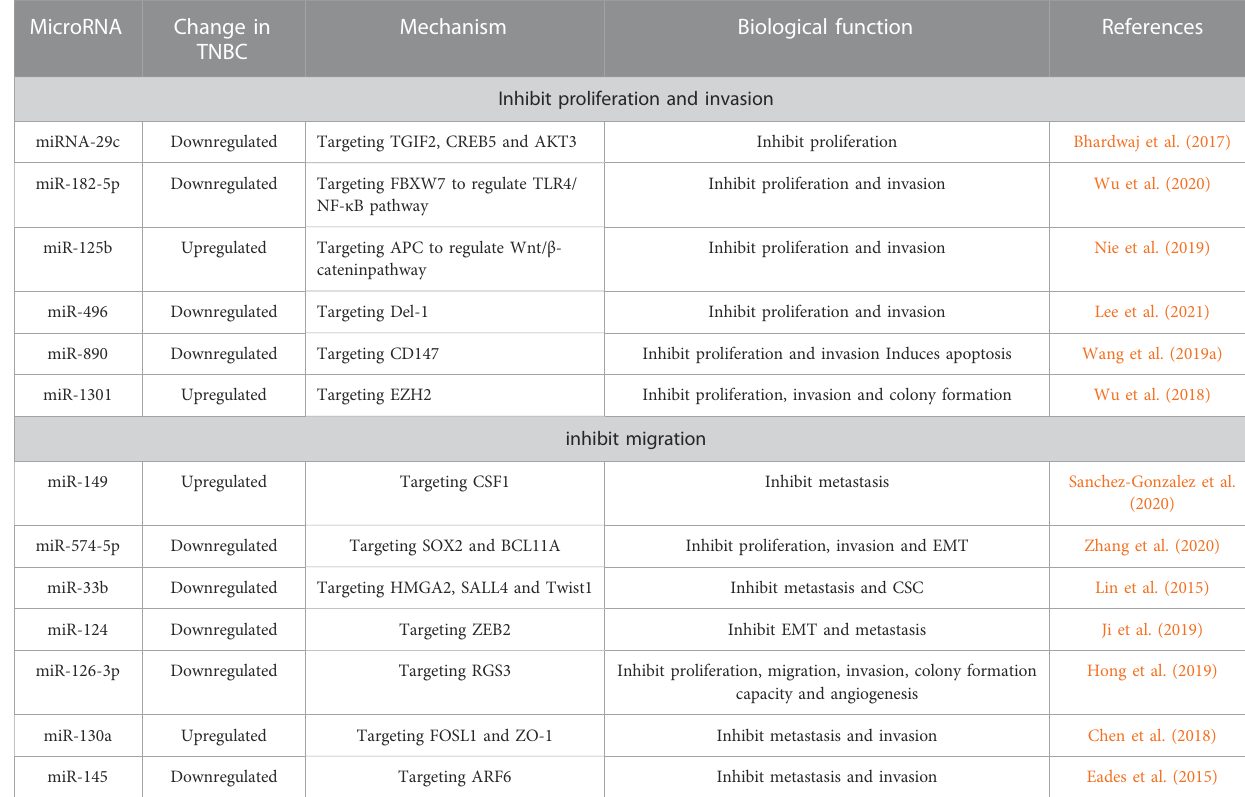
TABLE 3 MicroRNAs inhibit